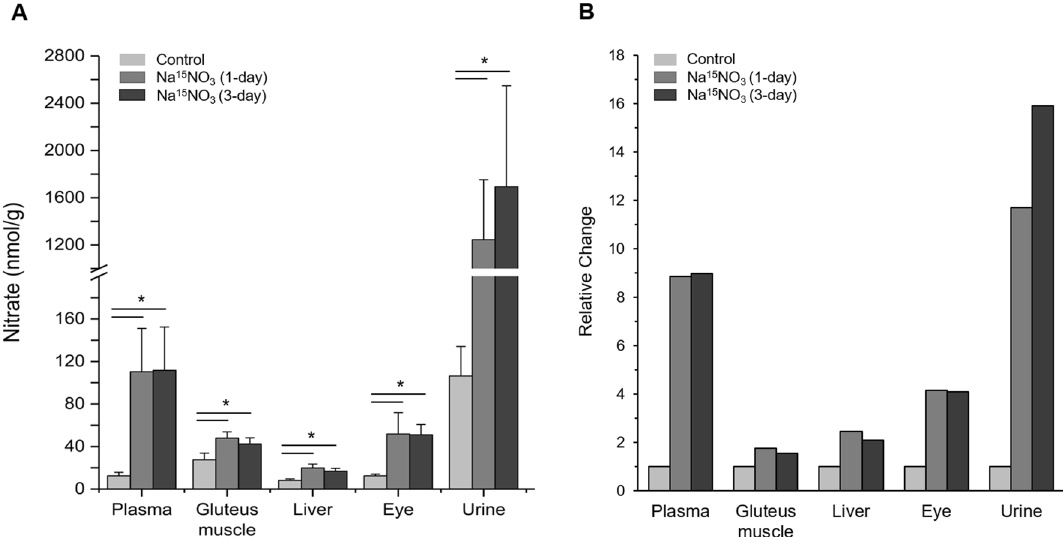
Figure 1. Total nitrate concentrations in rat tissues. ( A ) Tissue samples were homogenized by a rotary homogenizer, then centrifuged (17,000 g, 30 min) after mixing with methanol for deproteinization 40 . The supernatant was used for nitrate measurement by a standard chemiluminescence method with vanadium chloride. Data are plotted as average ± standard deviation (n = 4–6, * p < 0.05). ( B ) The change in each organ at 1-day and 3-day Na 15 NO 3 supplementation (1 g/L) relative to control.